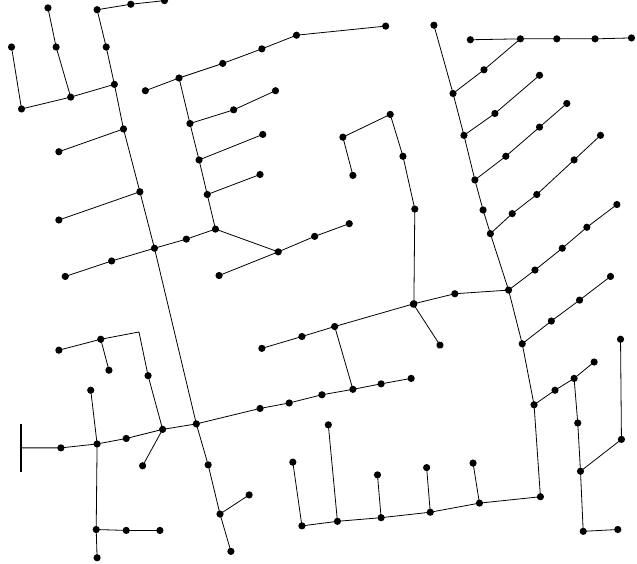
Figure 3. Topology of the 4.16 kV IEEE 123 node test feeder